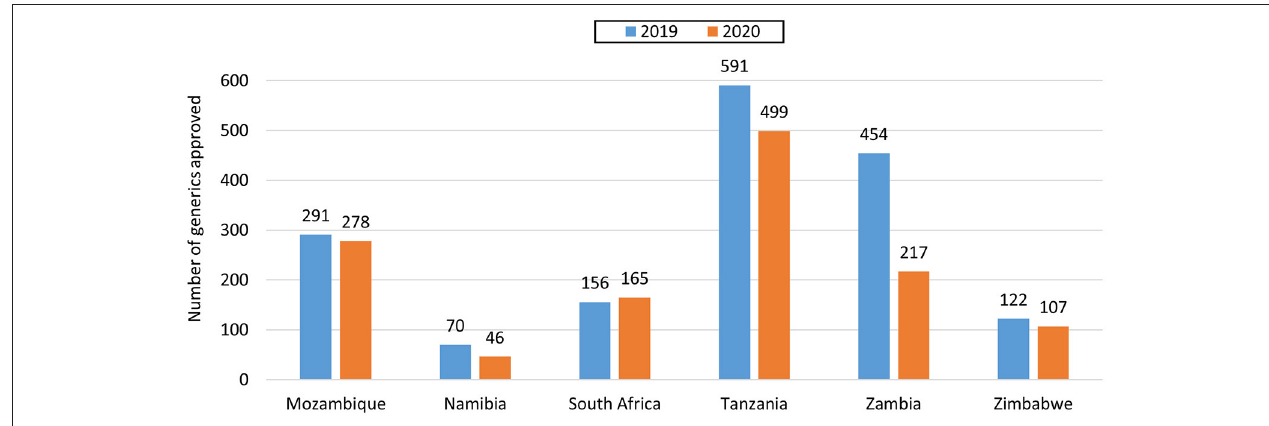
FIGURE 1 | Comparison of number of generics approved in 2019 and 2020.